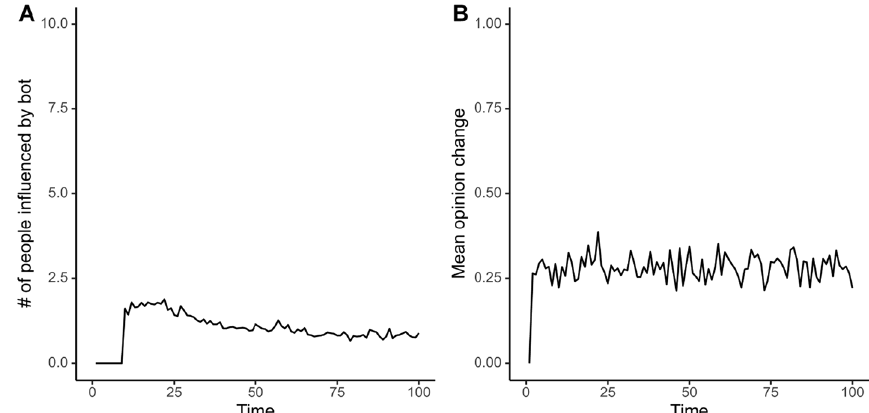
Fig. 3 Direct bot influence. (a) The average number of nodes influenced by the bot on each timestep. Influence is defined as when an agent is presented with content produced by the bot, engages with this content, and shifts its own opinion. (b) Mean opinion change for agents influenced by the bot on each timestep. A single bot can influence multiple people on each timestep and produce substantial